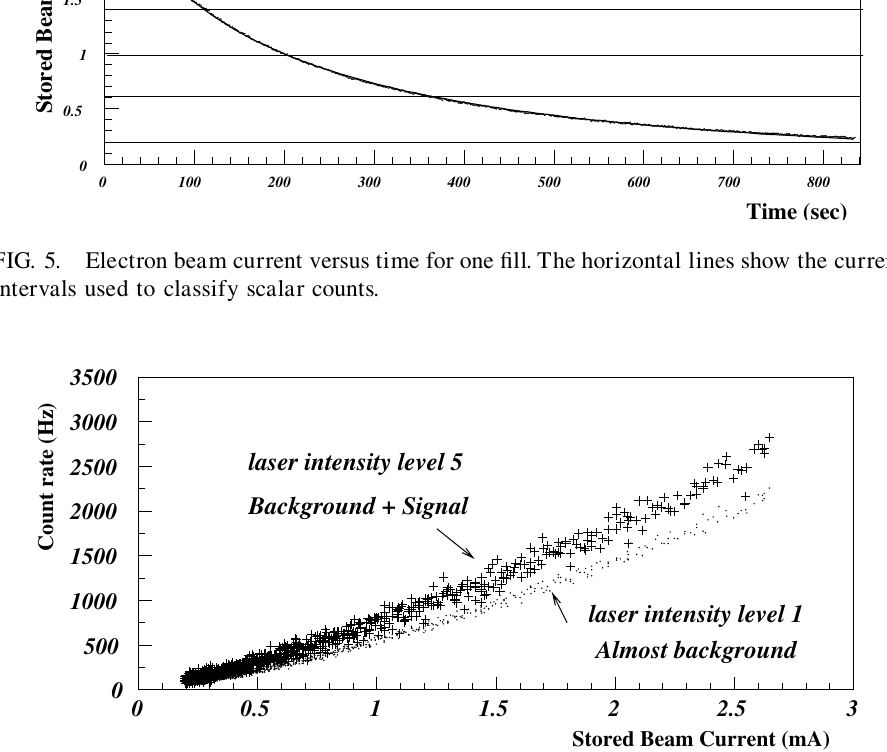
FIG. 6. Raw count rate versus electron beam current. The cross points show laser-on data (laser intensity level 5) while the dotted points show laser-off data (laser intensity level 1).